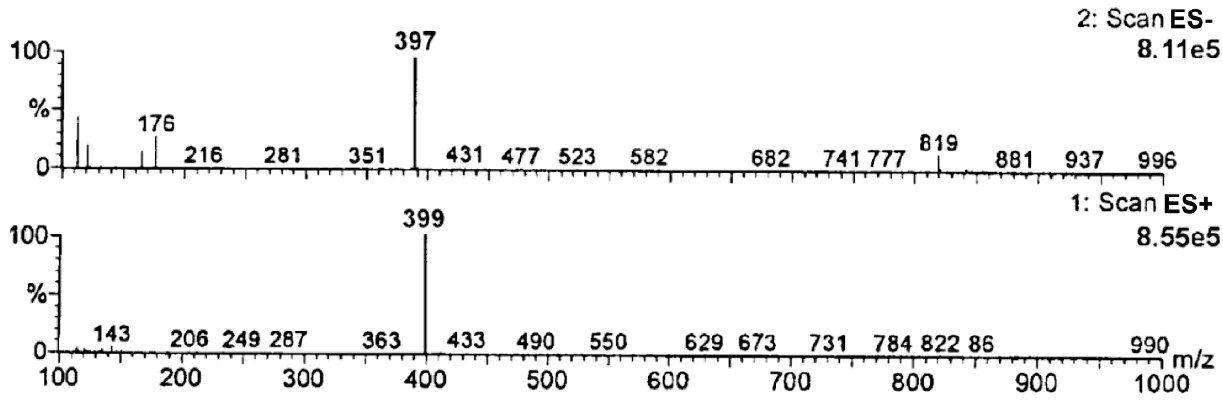
Figure 4. Mass spectra of RAM degradation impurity (t R about 7 min).